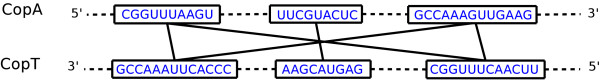
An example for interaction matching algorithm. Possible interactive accessible regions of CopA and CopT.